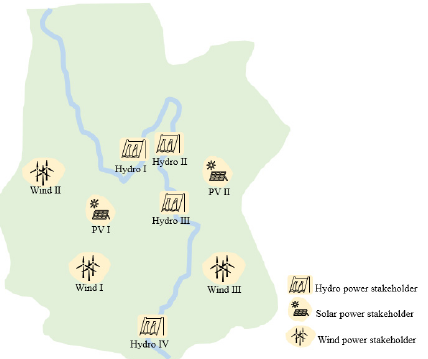
Figure 2. Diagram of wind–solar–hydro hybrid generation system in Yalong River basin.